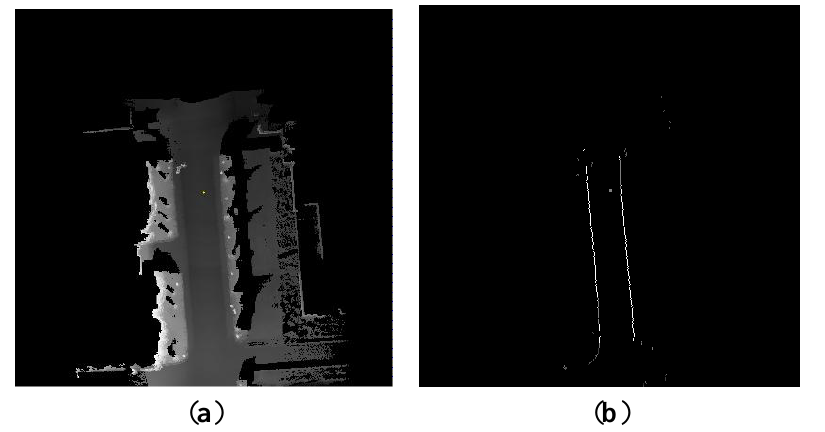
Figure 6. The accumulated results of the curb candidates. ( a ) The local DEM. ( b ) The accumulated curb candidate points in the local